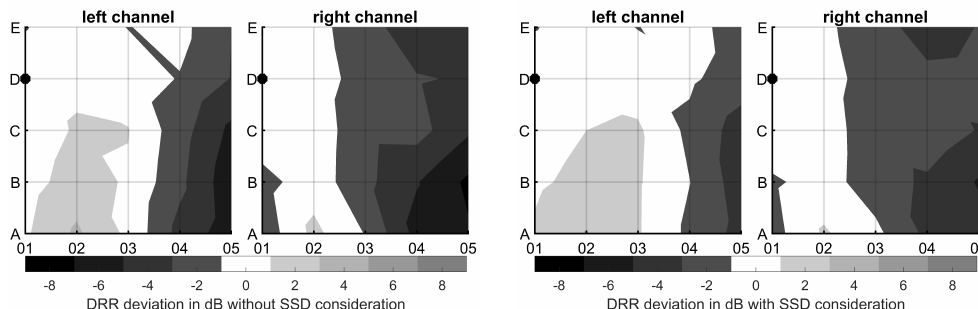
Figure 9. Deviation of broadband DRR between synthesized and measured BRIRs for incidence angle of 30 ◦ . Left the results for BRIRs without SSD consideration, and right with SSD consideration are shown. The Black dot represents the measured position for the synthesis “D1”, active source “S1” is placed 1m below of position